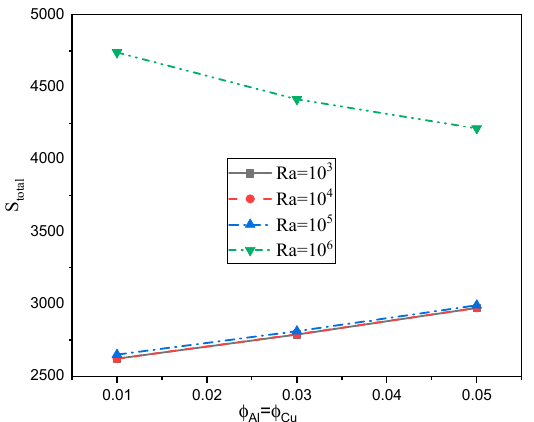
Figure 11. Profiles of the S total in the entire domain for the variation of the Rayleigh number and nanoparticle volume fraction φ Al = φ Cu at Ha = 15, H = 0.1, γ = π /6, Φ = π